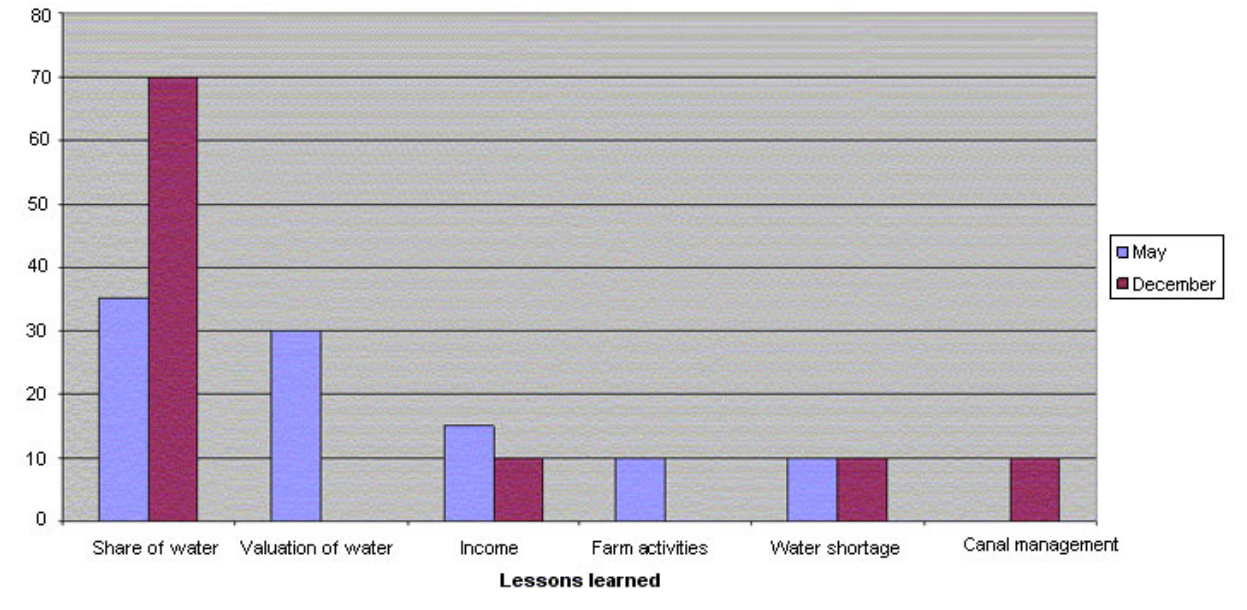
Fig. 4. Lessons learned by players from the two gaming sessions in May and December of